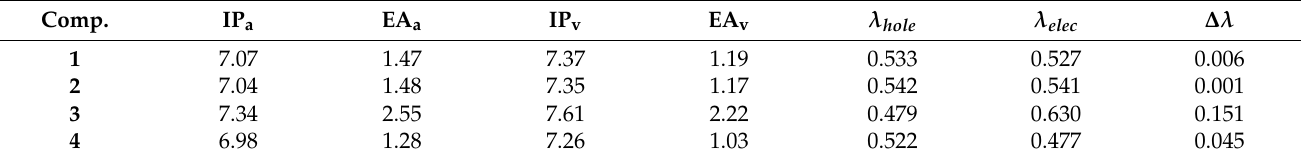
and hole/electron reorganization energies ( λ hole / λ elec ) in eV of Schiff derivatives at B3LYP/6-31+G(d,p)